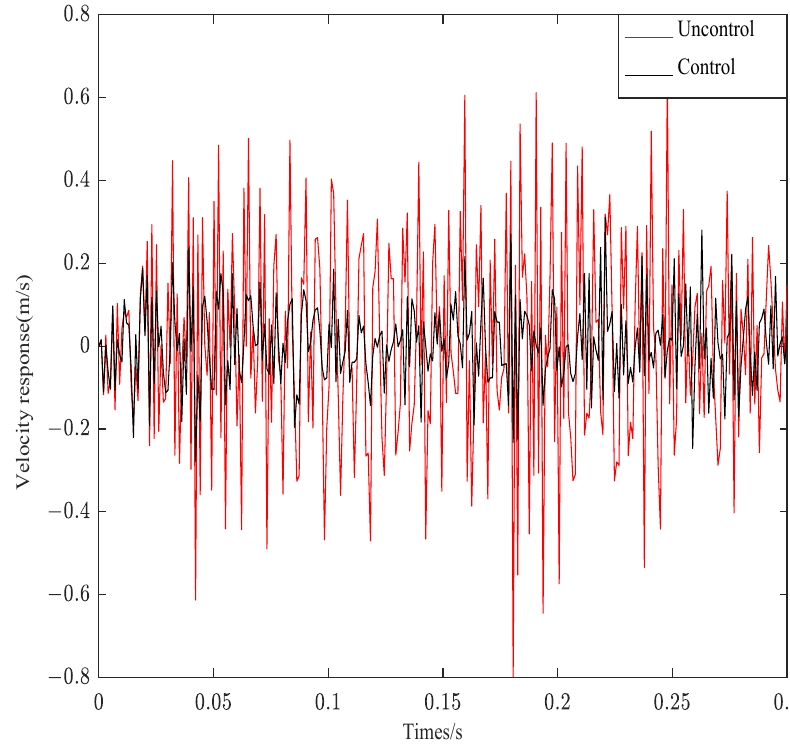
Figure 16 is the response curve of structure 3 under white Gaussian noise. Figure 15. Velocity response under complex aperiodic signal. Figure 15. Velocity response under complex aperiodic signal.